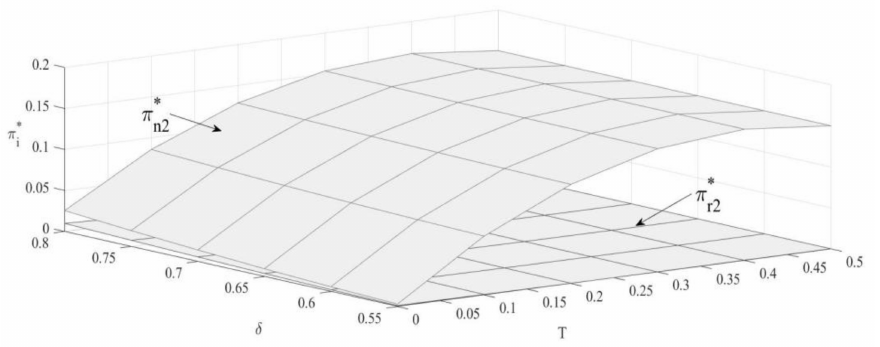
Figure 3. The impact of T and δ on